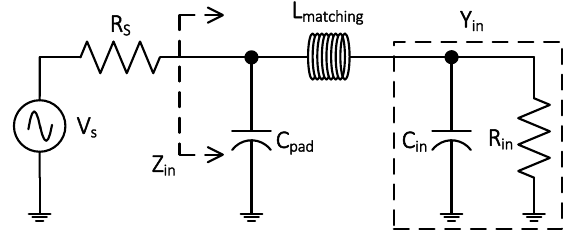
Figure 5. Equivalent model of input matching circuit accounting for the parallel input resistance and capacitance, R in and C in , respectively, along with pad capacitance, C pad